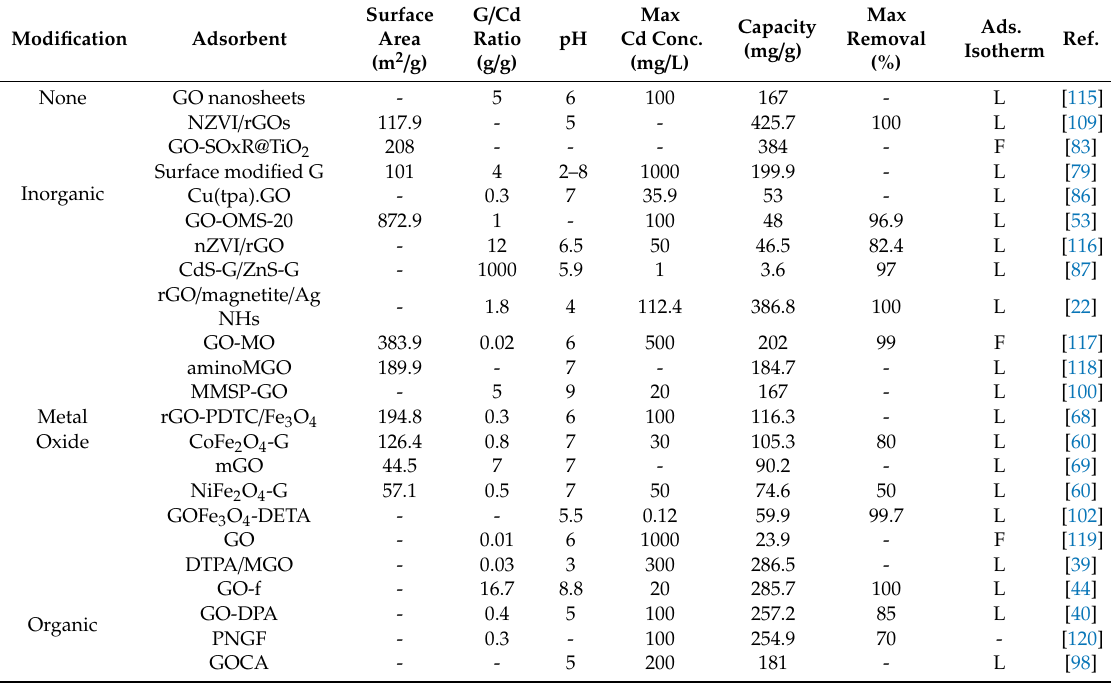
Table 4. Adsorption properties of multiple GO-based adsorbents used in Cd (II)